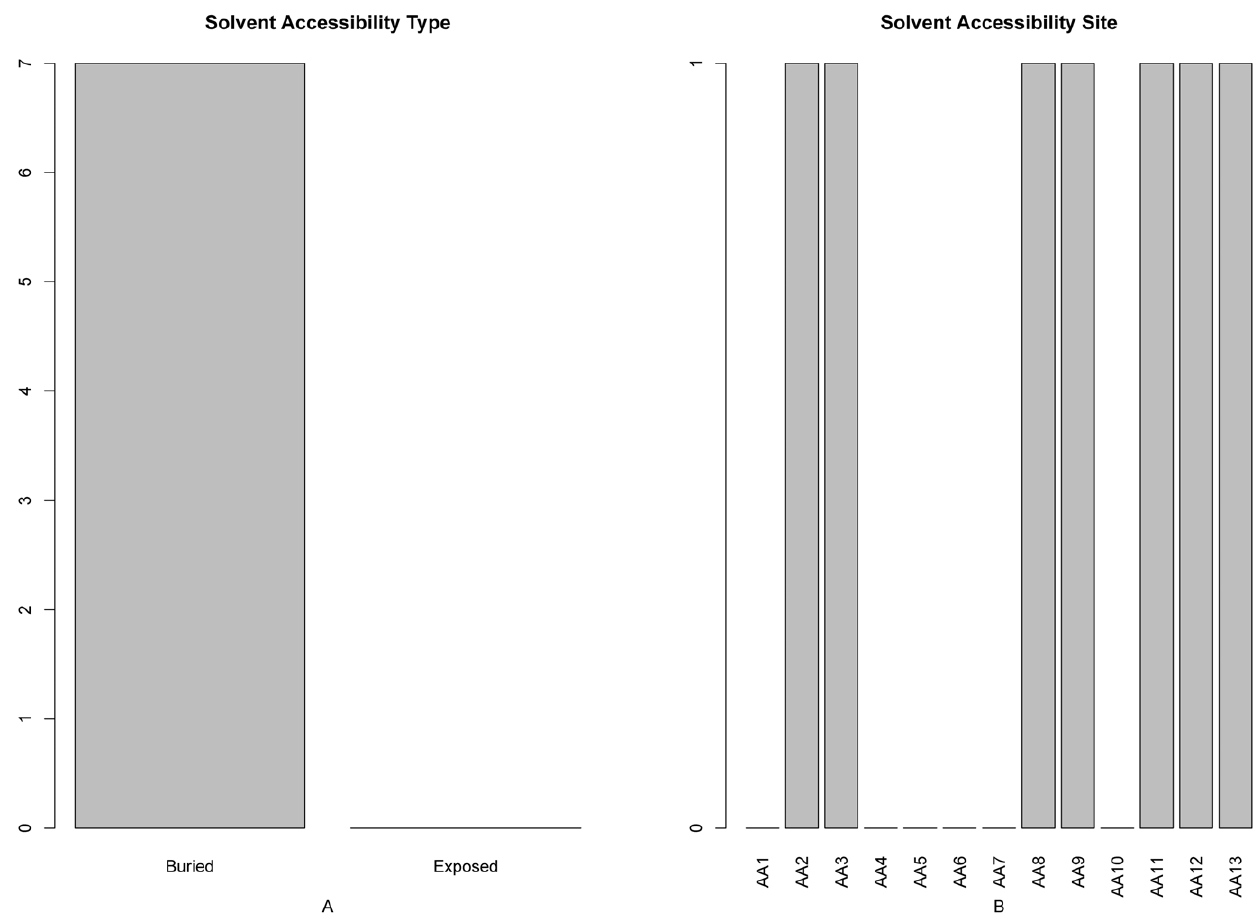
Figure 5. A 2-dimensional histogram to characterize the solvent accessibility types in the final optimal features set. The impact on the protein domain prediction from ( A ) the two different types of the solvent accessibility, and ( B ) each of the 13 subsites. See the text for further explanation.